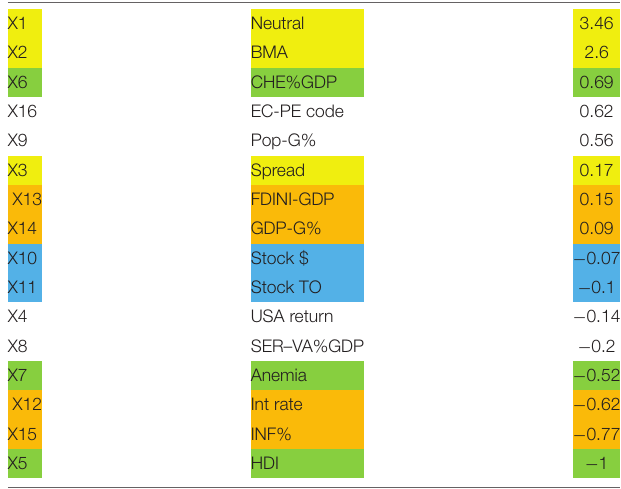
TABLE 16 | Feature Importance in China Testing